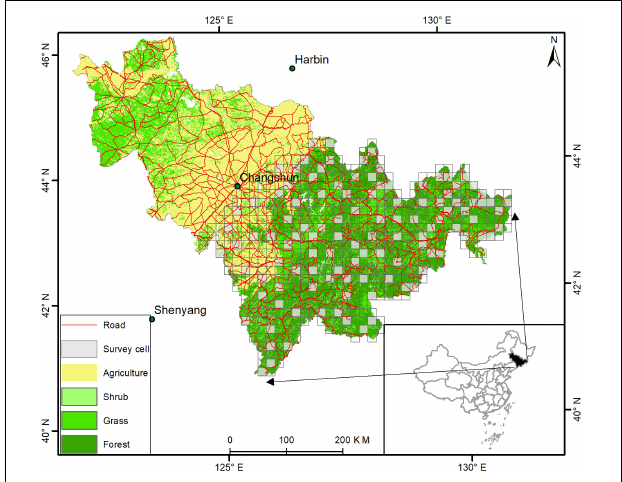
FIGURE 1 | Grids (15 km × 15 km) where the survey was taken (gray cells; n = 112) during 2015–2019 in Jilin Province, China.